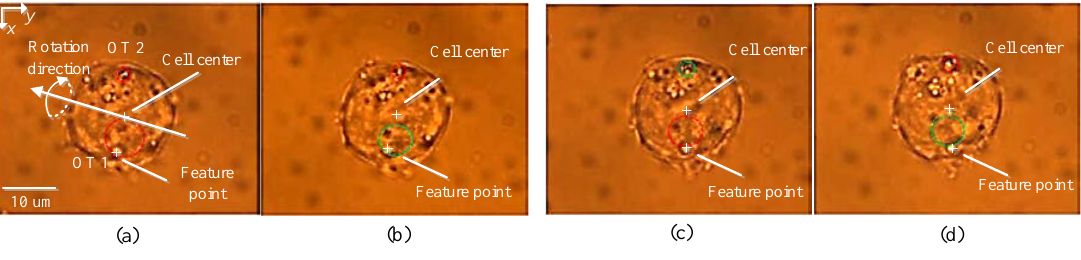
Figure 3. Snapshots of cell out-of-plane rotation control using two optical traps. ( a ) 0 s; ( b ) 0.25 s; ( c ) 2 s; ( d ) 5 s. Reproduced with permission from [35].